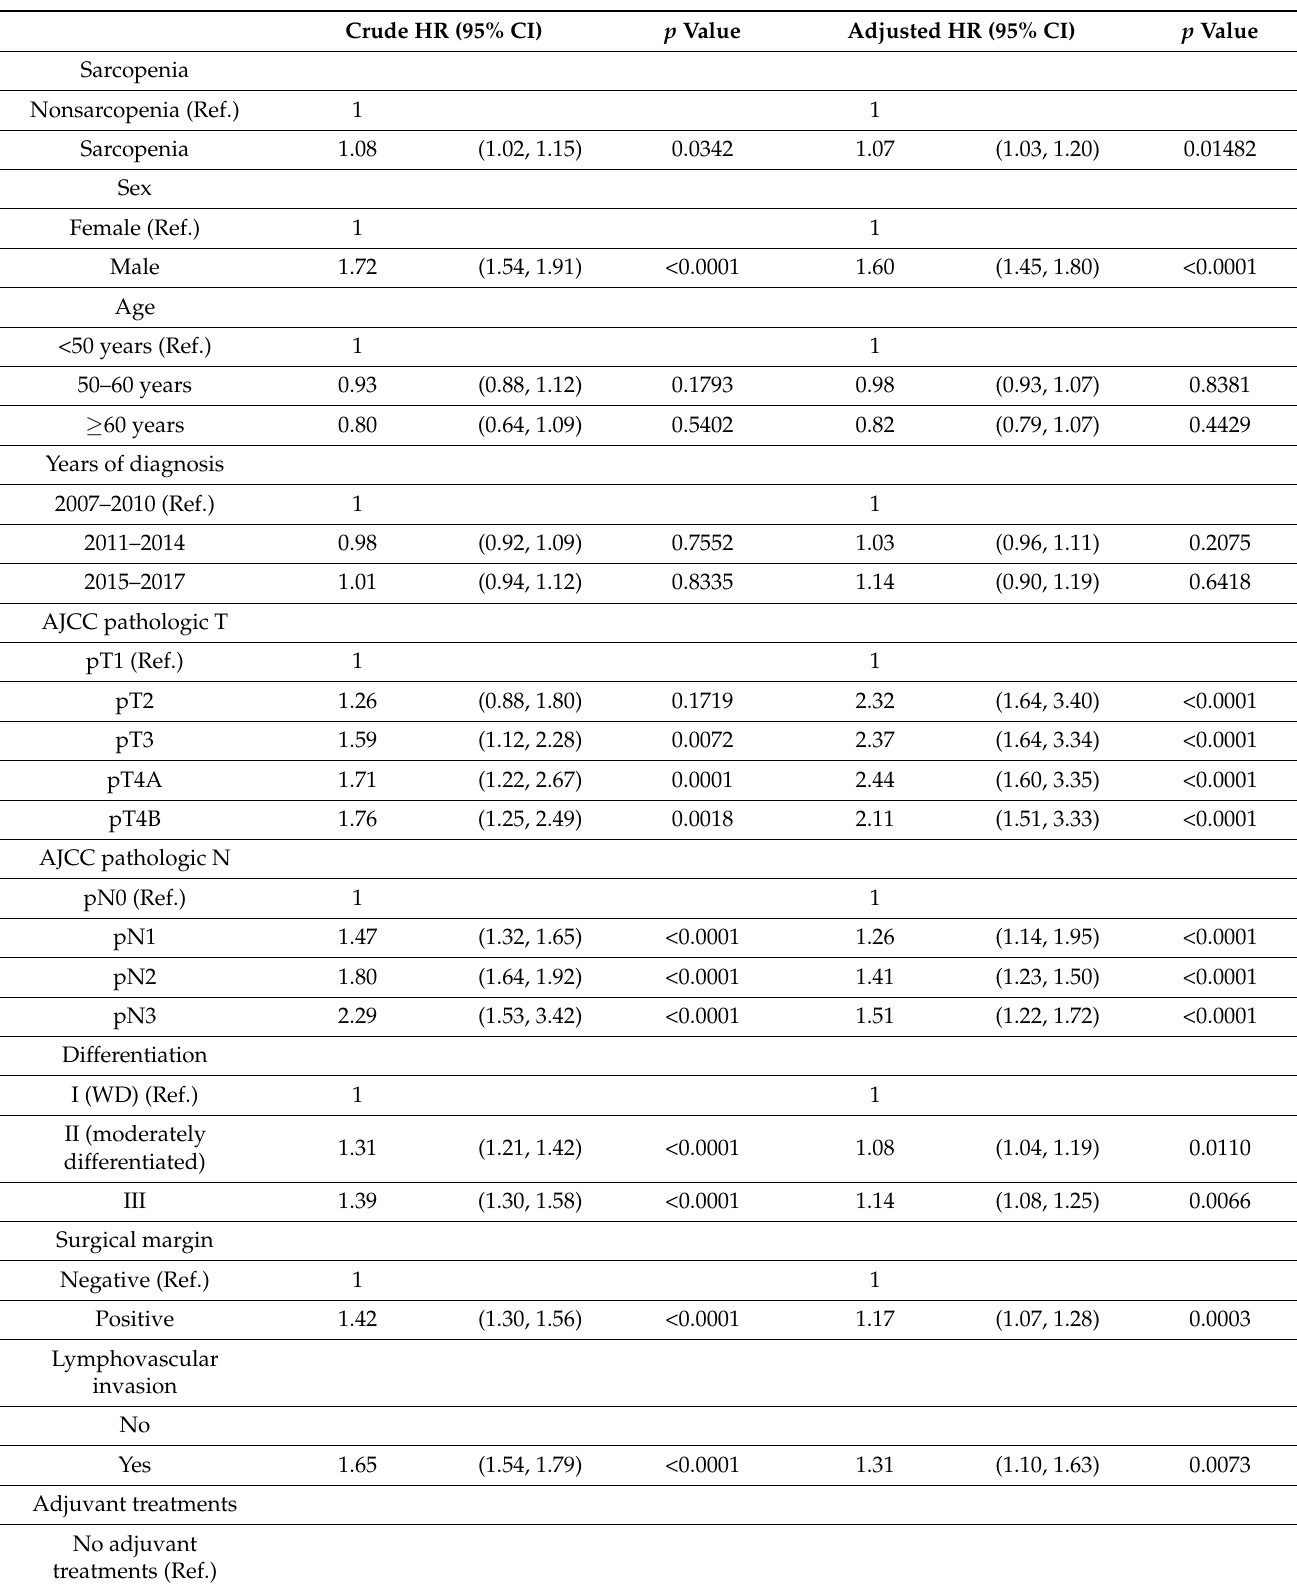
Table 4. Univariable and multivariable Cox proportional regression model for distant metastasis of the propensity score-matched groups of patients with oral cavity squamous cell carcinoma with and without pre-existing